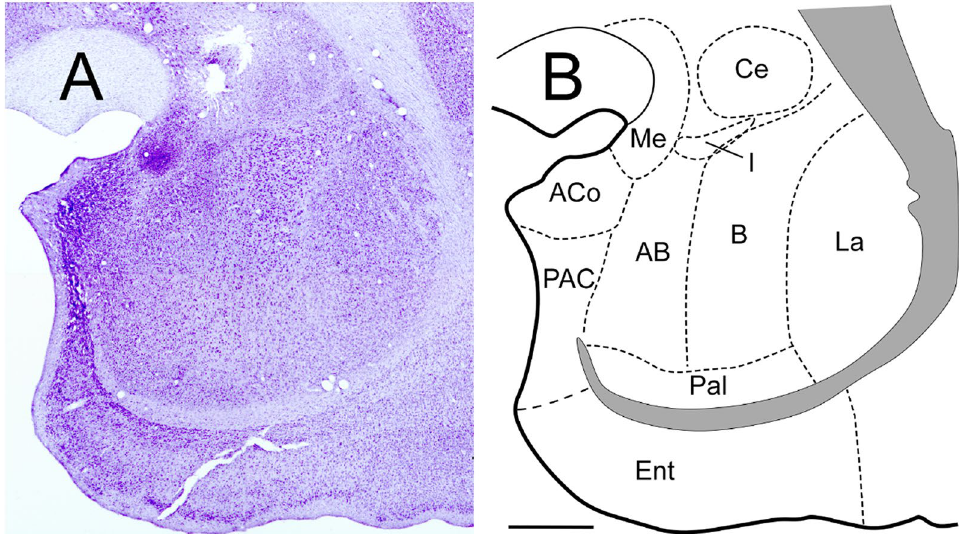
Figure 8. Amygdala of the marmoset (details in Morais et al.41). Coronal section of the amygdala at middle level ( A ) and schematic draw ( B ) of the amygdala nuclei. Scale bar: 1000 µm. The figure was drawn in Canvas software version